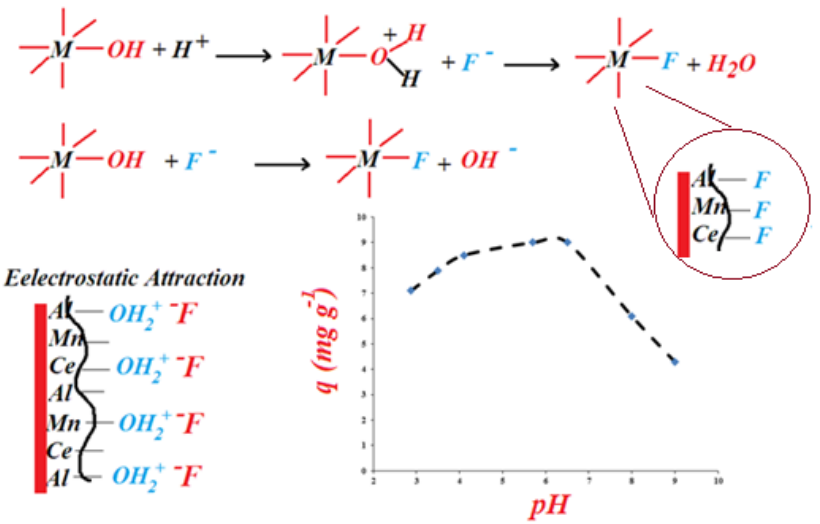
Fig. 6, F- adsorption mechanism and effect of pH on adsorption capacity